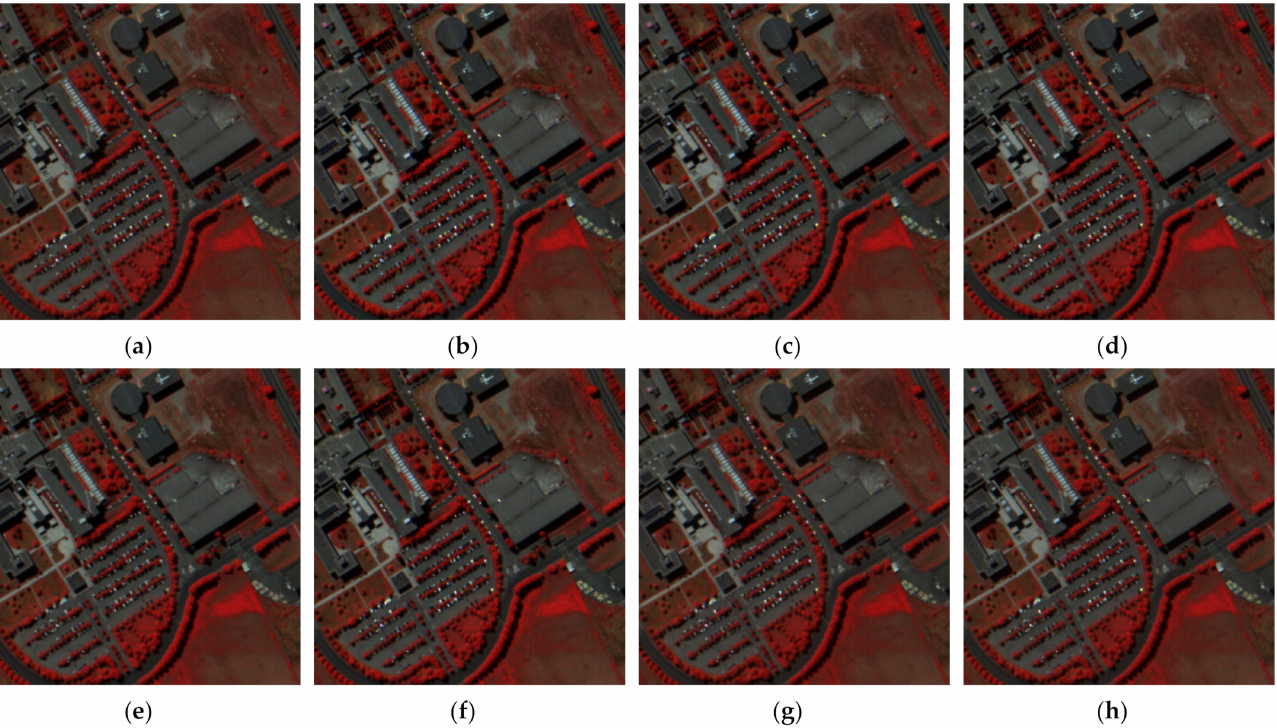
Figure 4. Results of Pavia University dataset with simulated multispectral images. ( a ) results of GSA; ( b ) results of SFIMHS;